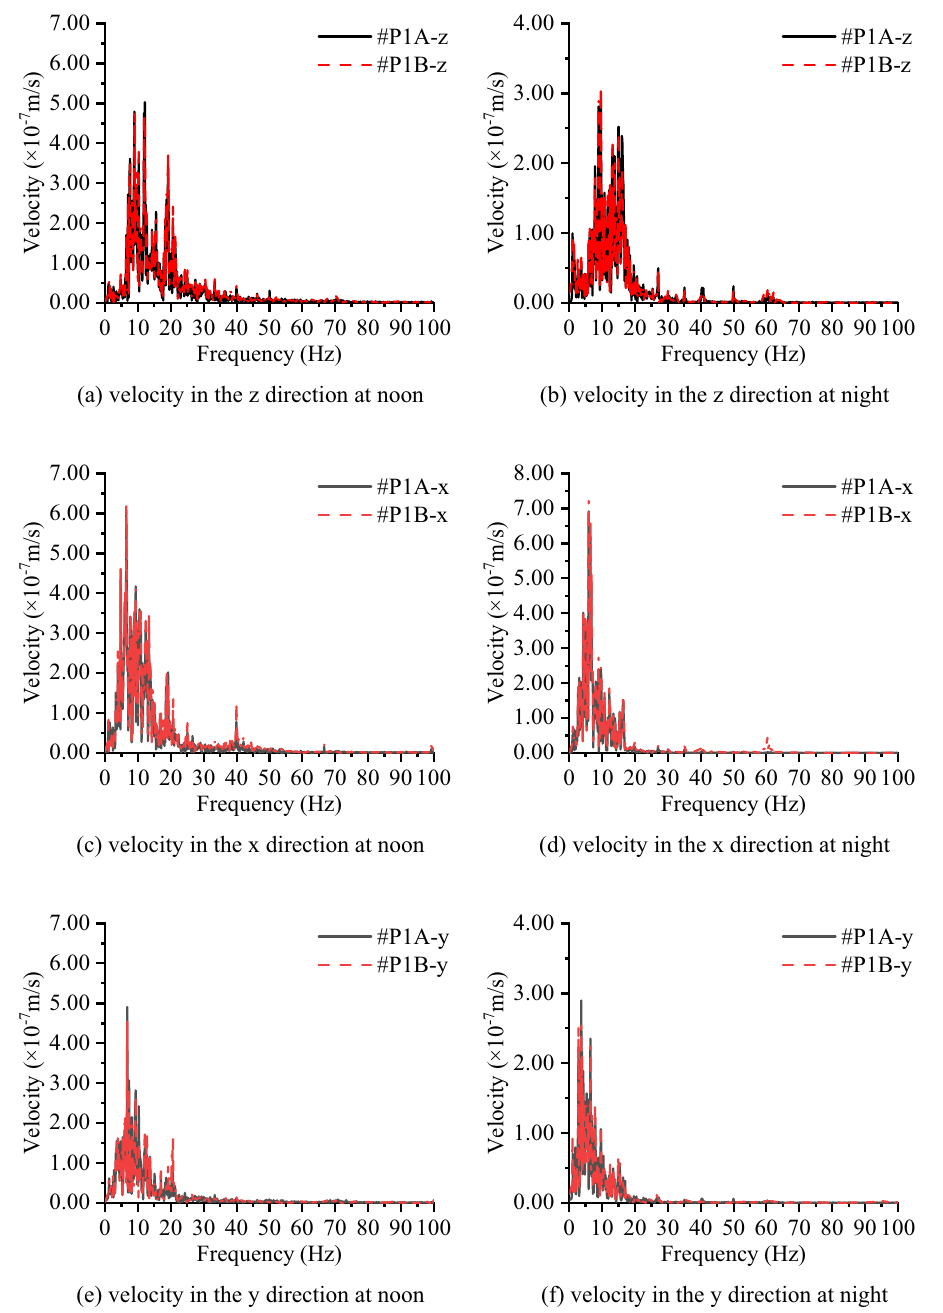
Figure 13. Frequency spectrum of the measured velocities on the concrete layer at a height of 0.4 m and 2.2 m on the concrete layer (group